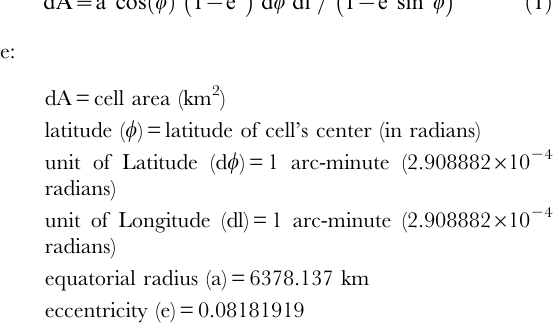
Figure S1 Map of the North Pacific Ocean and geo- graphic subdivisions used to generate discrete regions of benthos availability. See Table 1 for definitions. Figure S2 Benthic sampling profile of depth ranges within 75 m diving depth of gray whales during the last 120 ka. Table S1 Estimated benthos availability (km 2 ) within 75 m of the surface during the last 120 ka. See Materials and Methods for data source and treatment. Table S2 Estimated grey whale population sizes in the North Pacific during the last 120 ka under two